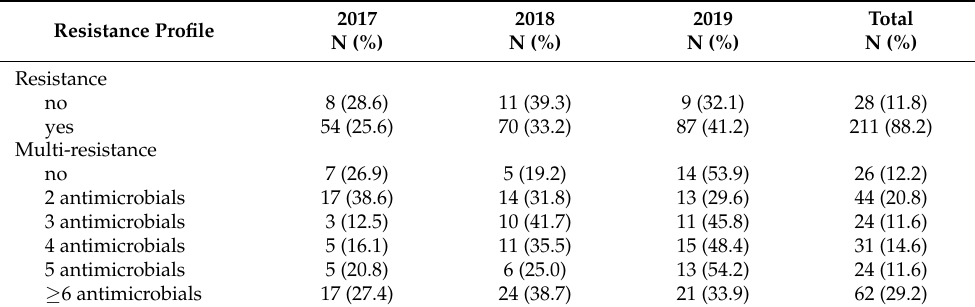
Table 2. Resistance profile stratified by survey’s